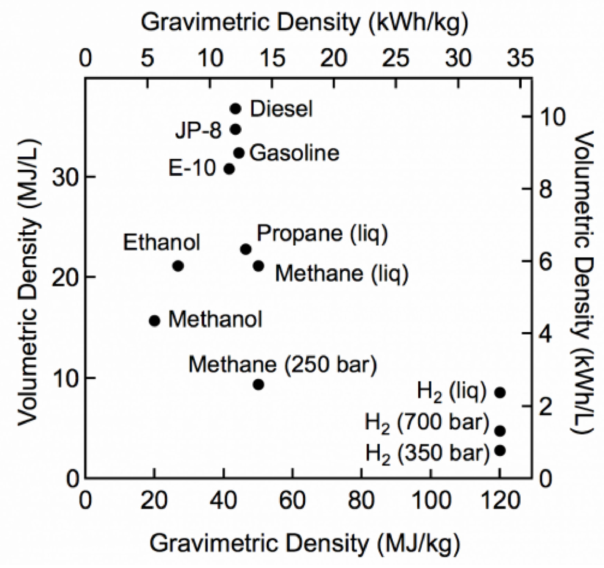
Figure 1. Comparison of specific energy (energy per mass or gravimetric density) and energy density (energy per volume or volumetric density) for several fuels based on LHV. Courtesy of the U.S. Department of Energy